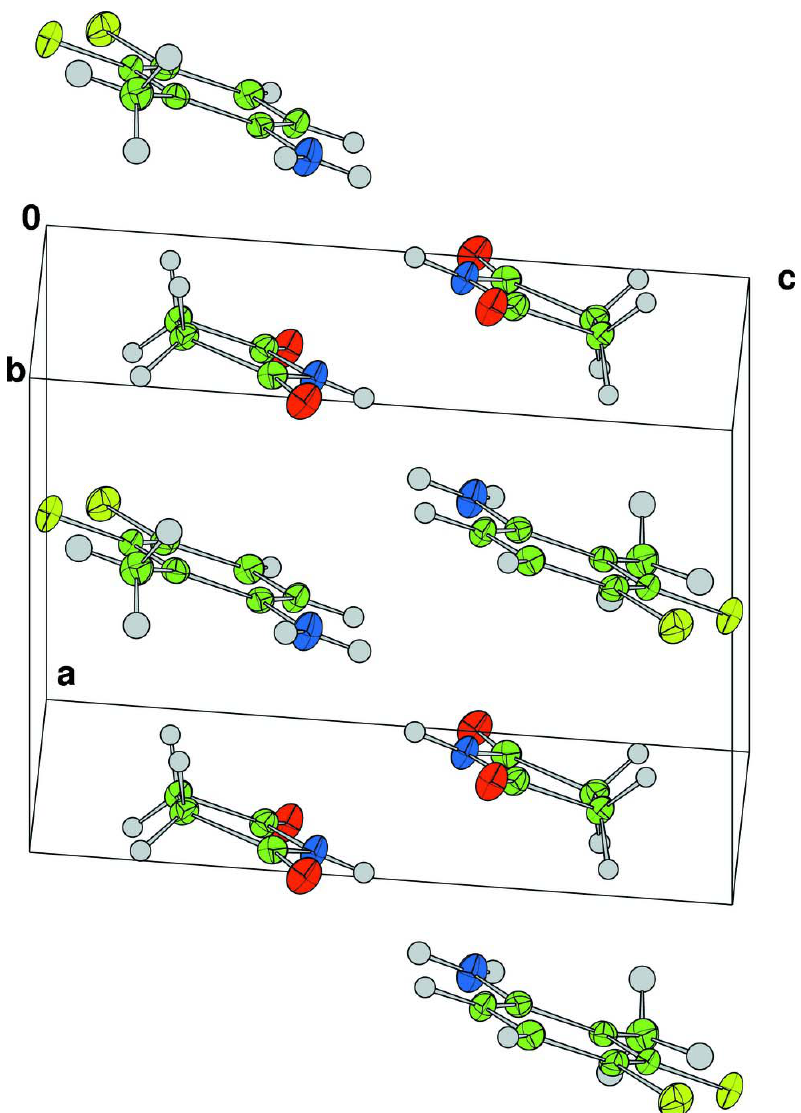
Figure 2 Plane-to-plane stacking of alternate molecules parallel to the a